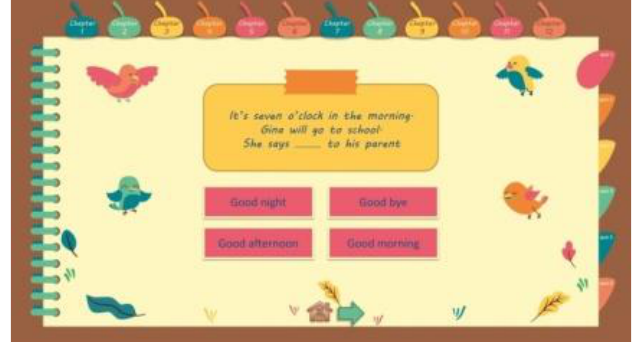
Figure 10. LEEF Quiz